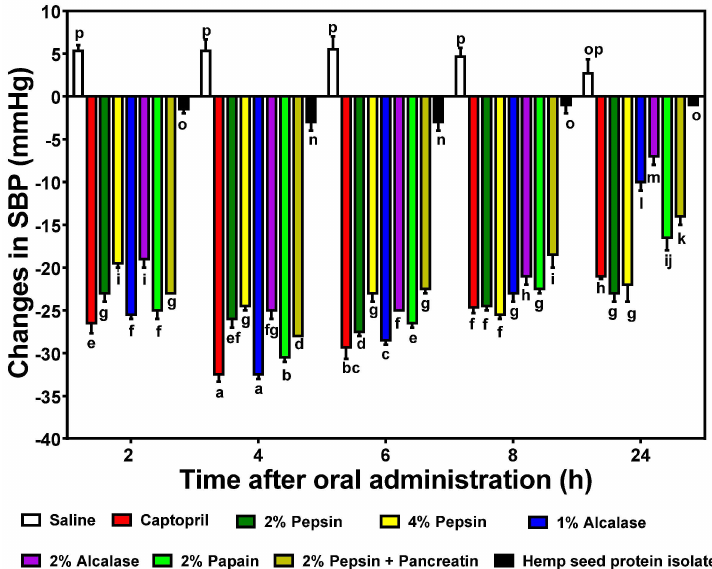
Figure 6. Time-dependent changes in systolic blood pressure (SBP) of spontaneously hypertensive rats (SHRs) after oral administration of different enzymatic hemp protein hydrolysates (HPHs) and hemp protein isolate